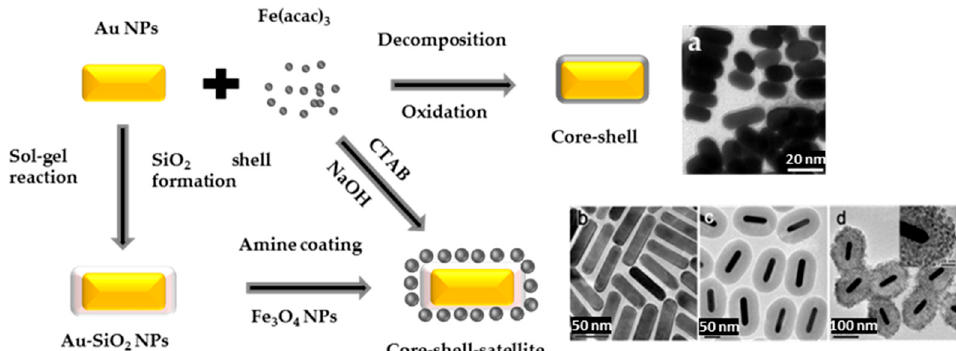
Figure 15. Non-spherical Au-Fe 3 O 4 core-satellite NSs starting from Au nanorods. ( a ) TEM images reproduced with permission from [85]. Springer Nature, 2012. While ( b – d ) ones reproduced with permission from [84]. American Chemical Society, 2016.